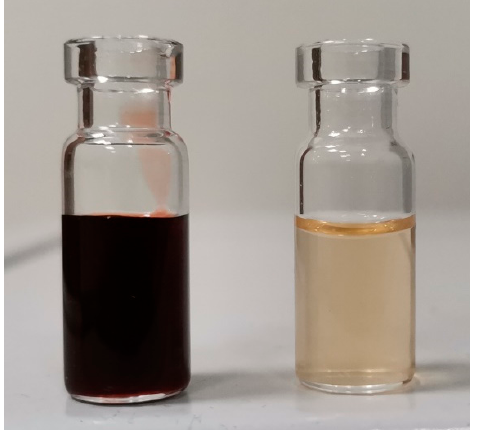
Figure 1. Extract Opt3 ( left ) vs extract ETOH 80% ( right ).